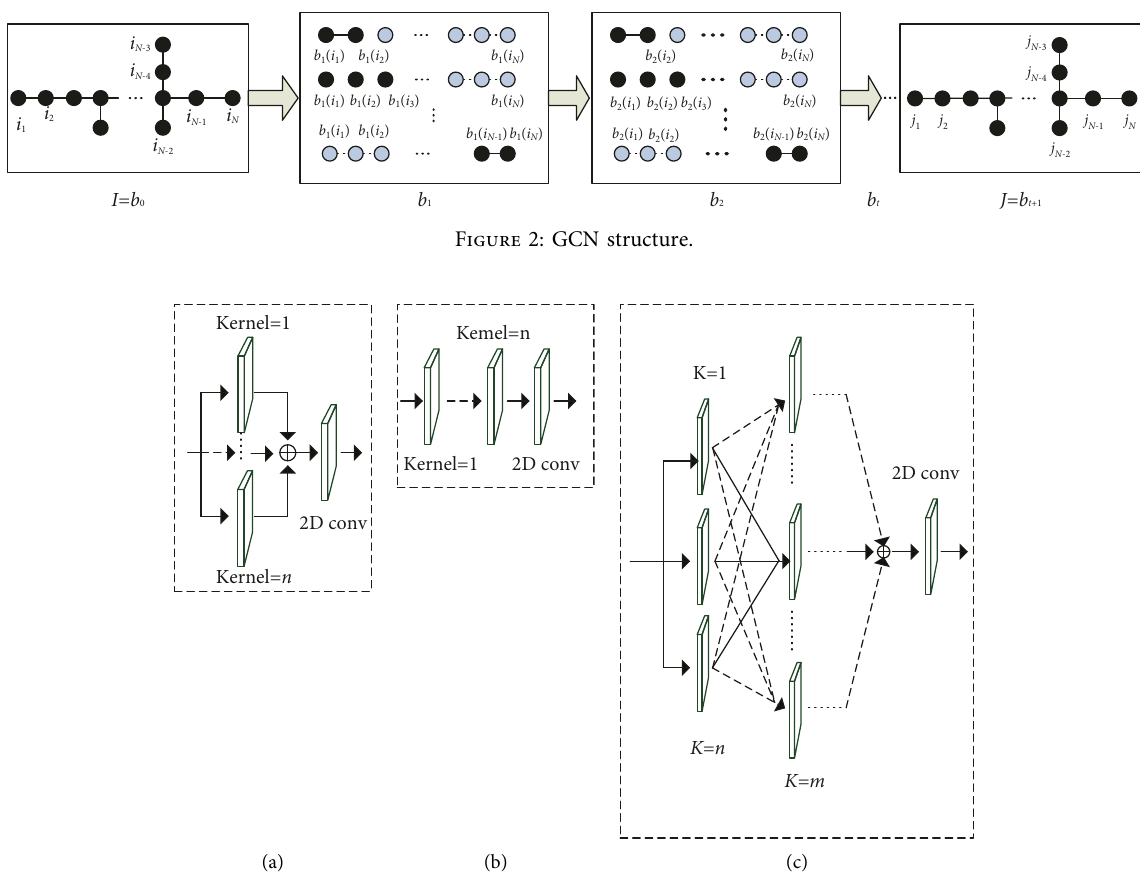
Figure 3: Multiscale graph convolution structure. (a) The architecture of multiple-parallel temporal block. (b) The architecture of multiple- serial temporal block. (c) The architecture of multiple-dense temporal block.